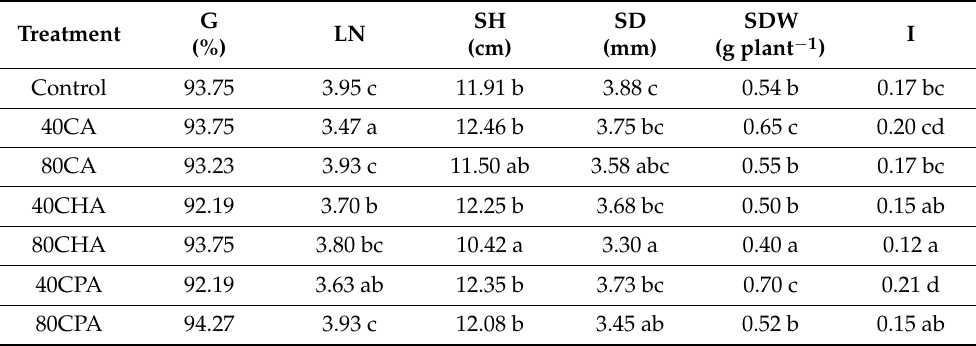
Table 5. Effects of treatments on the morphological characteristics of tomato seedlings (G: germina- tion; LN: leaf number; SH: shoot height; SD: shoot diameter; SDW: seedling dry weight; I: index of seedling